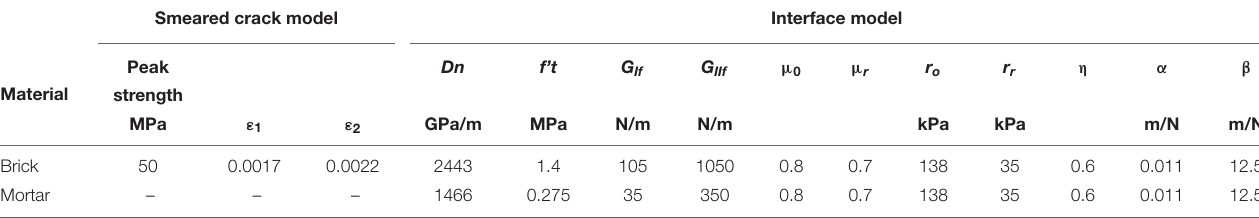
TABLE 1 | Material properties used in the numerical analysis of component